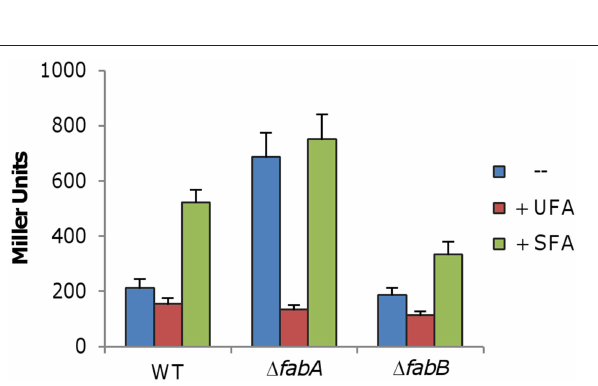
FIGURE 7 | Expression of desA under various conditions. The desA promoter was cloned into an integrative lacZ reporter, integrated into the chromosome of the relevant strains, and assayed the same as Figure 2 . Effects of fabA and fabB mutations, in combination with exogenous UFA (C18:1 1 9) and SFA (C16:0), were assessed. Experiments were conducted independently at least three times and standard deviations were presented as error